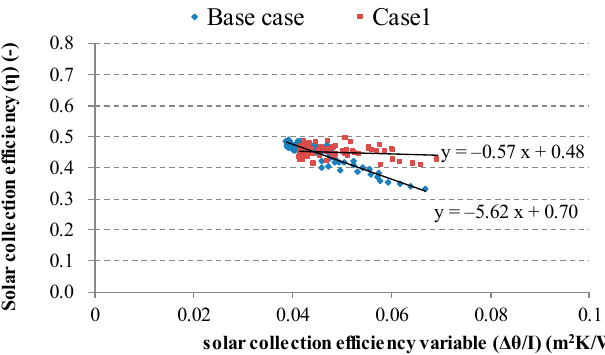
Figure 5. Comparison of the solar collection efficiency (base case and case 1).